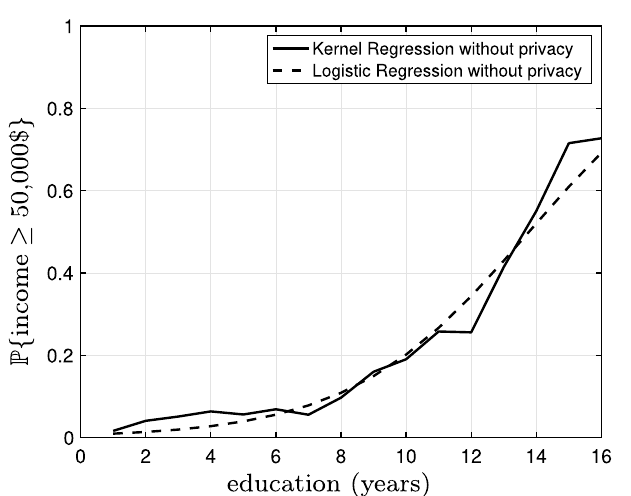
Figure 7. The kernel regression model (solid black) and the logistic regression model (dashed black) based on 0.17 . The logarithm of the likelihood for the kernel regression model is the original data with bandwidth h = 0.49 and the logarithm of the likelihood for the logistic regression model is −